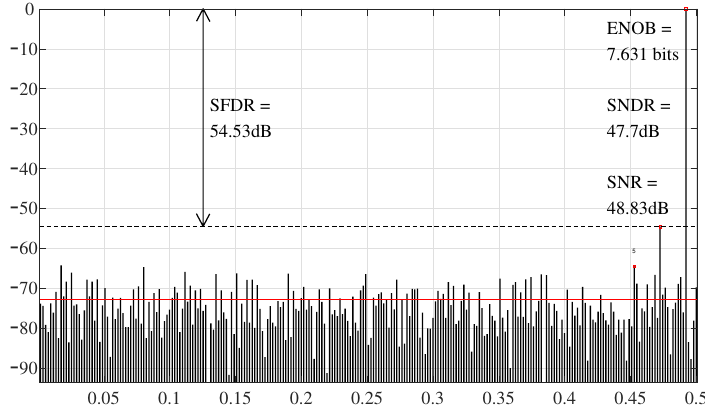
Figure 17. Simulated FFT spectrum at 32 MS/s with 15.7 MHz input of the ADC.